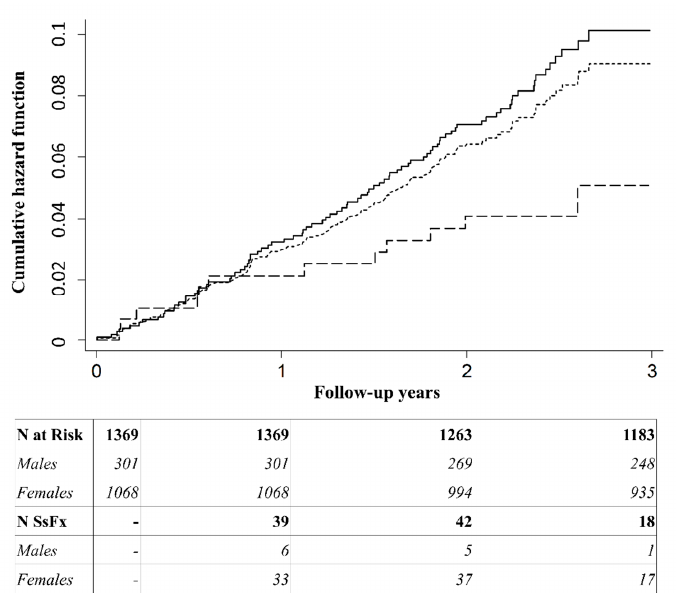
Figure 2. Nelson–Aalen cumulative hazard of subsequent fracture events after an index fracture in men and women aged ≥ 50 years over a period of three years of follow-up. Cumulative risk of subsequent fracture increased over the years following initial fracture. However, no significant differences were found in the incidence rate of subsequent fractures over 1, 2, and 3 years, regardless of sex and age. Dotted line represents the cumulative incidence of subsequent fractures in all subjects. Solid line represents the cumulative incidence of subsequent fracture events in females. Dashed line represents the cumulative incidence of subsequent fracture events in males. SsFx: subsequent fracture. The Y-axis represents the cumulative hazard function. The X-axis represents follow-up years after the first fracture.